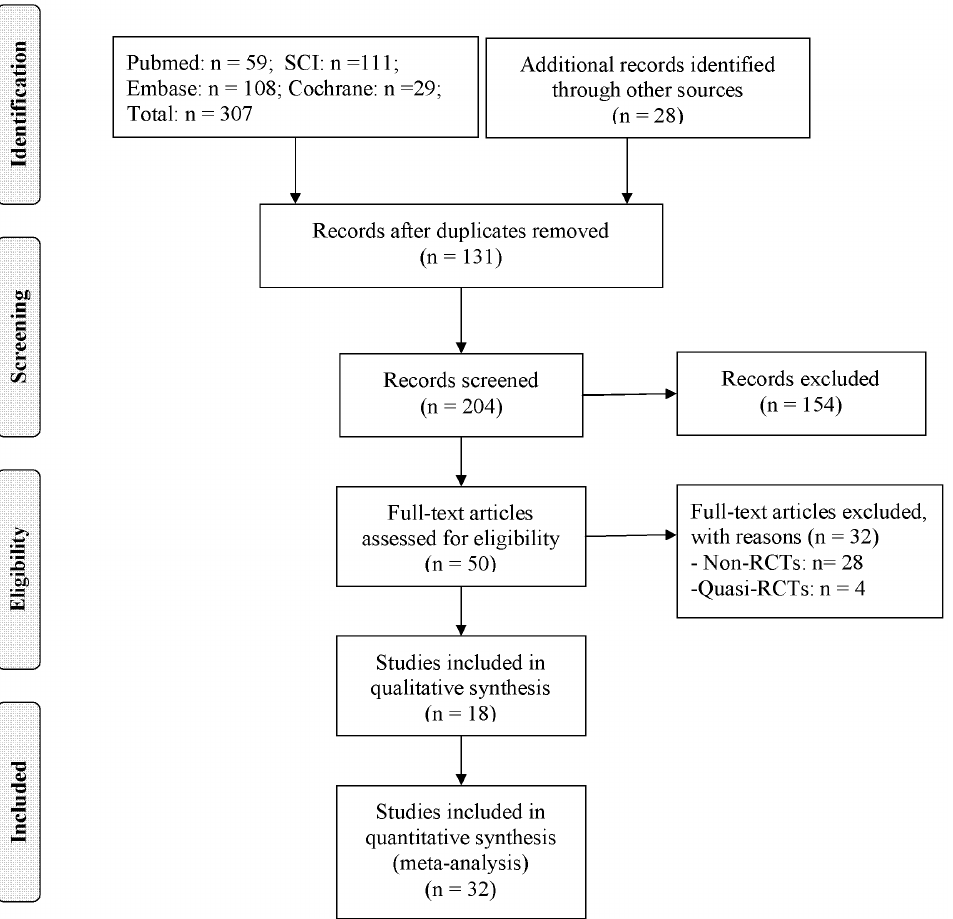
Figure 1. Flow chart of literature screening.